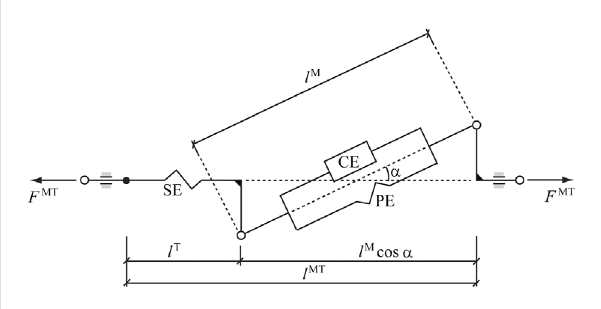
FIGURE 3 Hill-type musculotendon model. The muscle fi bers are modeled as an active contractile element (CE) in parallel with a passive elastic component (PE).Theseelements areinseries with anon-linear elastic tendon (SE). The pennation angle α denotes the angle between the muscle fi bers and the tendon. Superscripts MT, M, and T indicate musculotendon, muscle fi ber, and tendon,